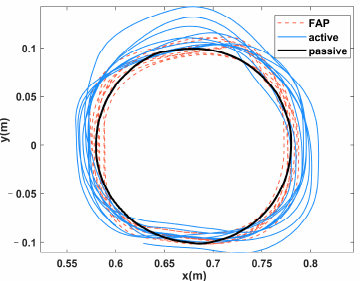
Figure 12. Partial task trajectory diagram of S1 in three modes.